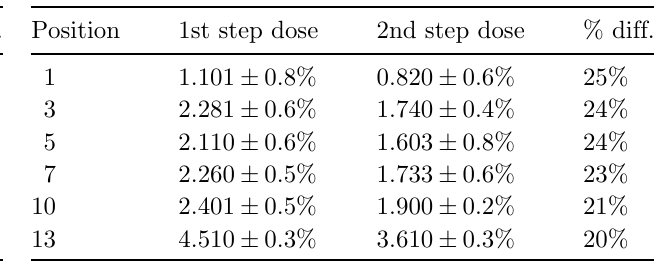
Fig. 6. Particles contribution to the total dose: relative contribution. Table 6. 1st and 2nd simulated doses in 10 (cid:4) 14 Gy/pot, in different positions at